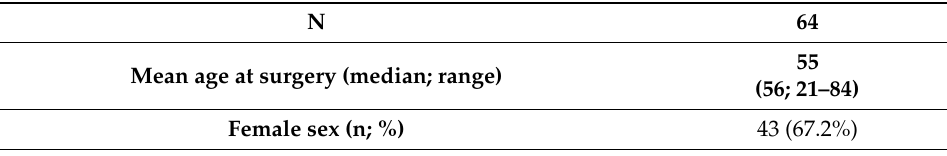
Table 1. Baseline characteristics of study cohort. N, number; mm, millimeters; CNS WHO, Central Nervous System World Health Organization grading system. N